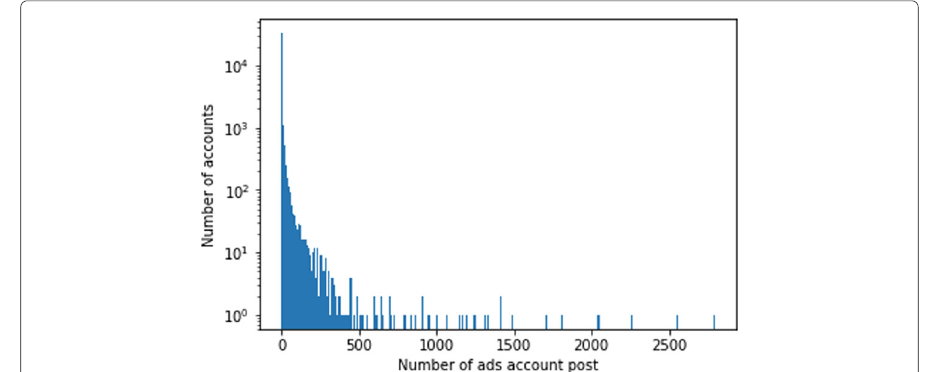
Fig. 5 A distribution of account sizes in terms of number of ads posted by that